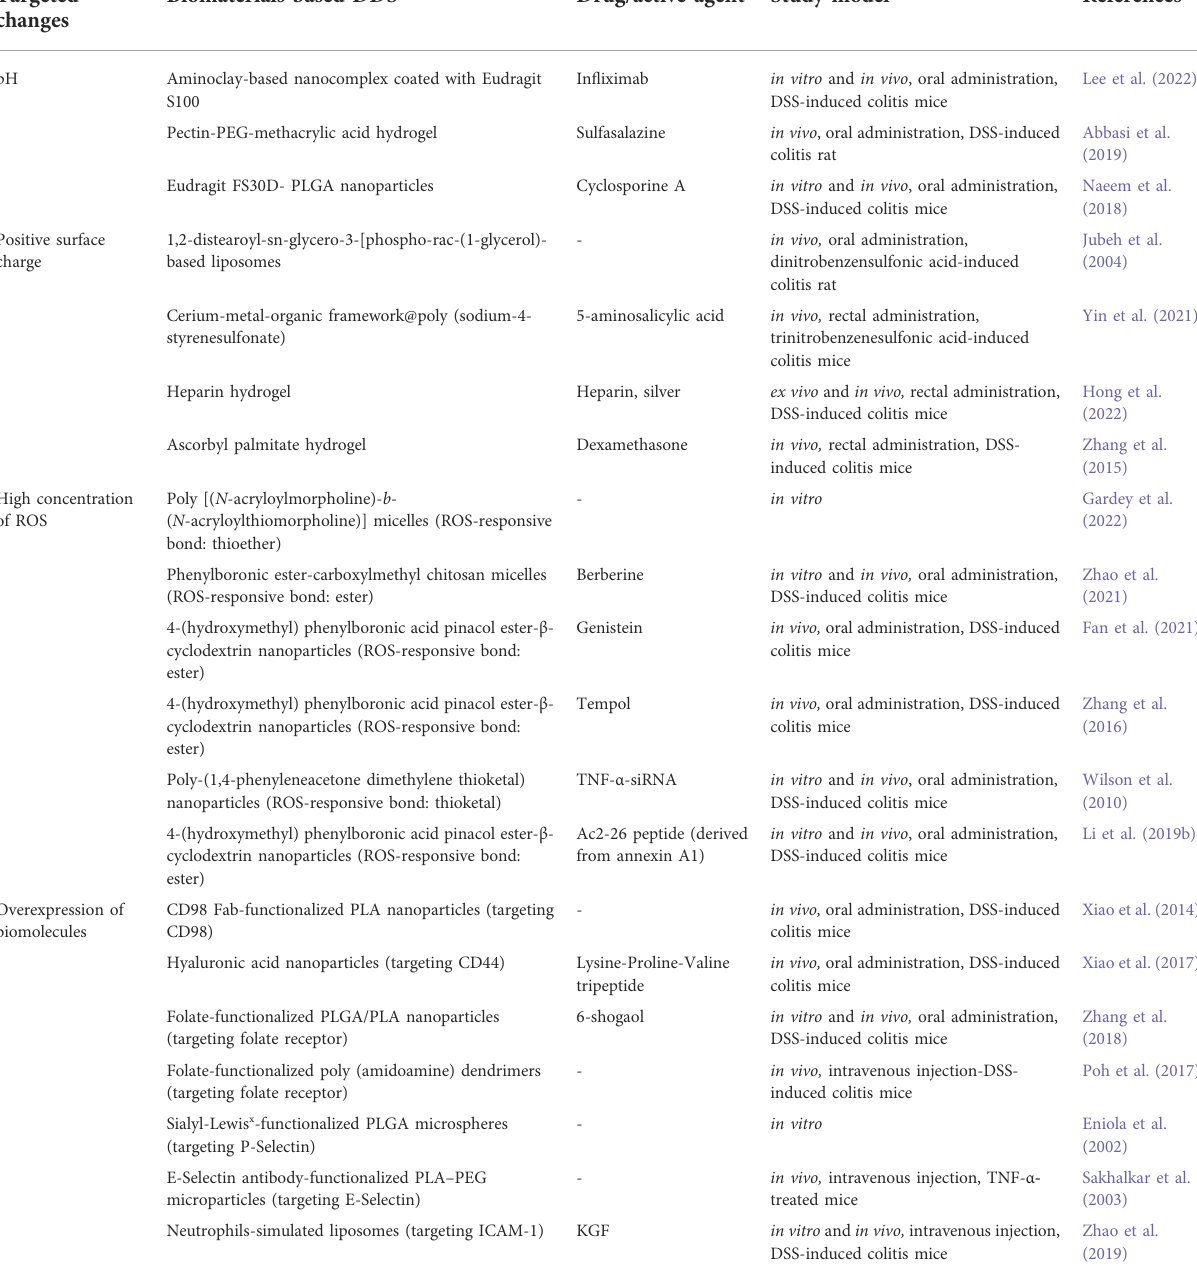
TABLE 1 Summary of studies on targeting pathophysiological changes using biomaterials-based drug delivery system (biomaterials-based DDS). Targeted